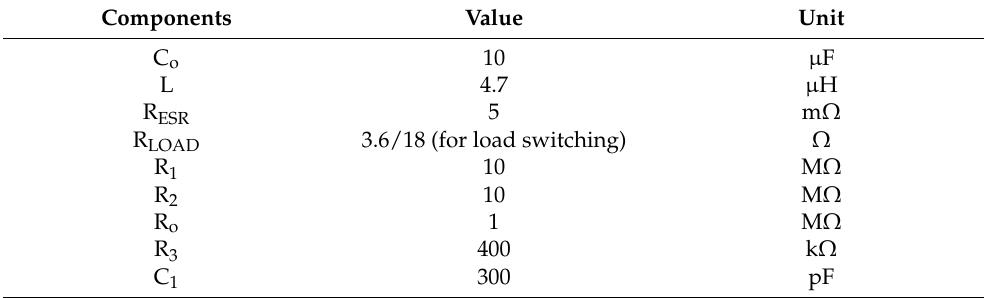
Table 1. Component Table 1. Component parameters.